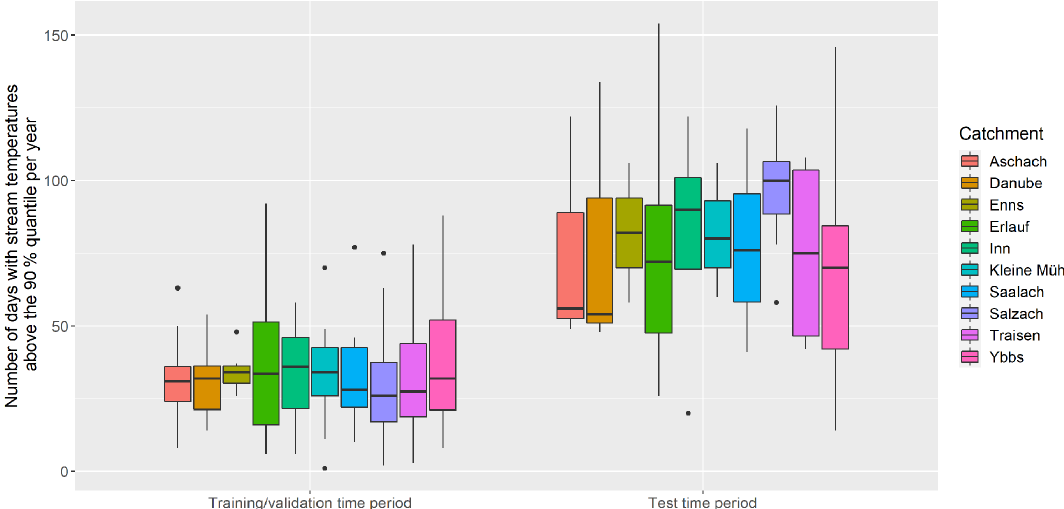
Figure 3. Boxplots showing the distribution of numbers of days with stream temperatures above the 90% quantile per year for all study catchments for the training/validation and the test time period, where the test time period consists of the last 20% of data in each catchment. The 90% quantile values were estimated using the full time series for each